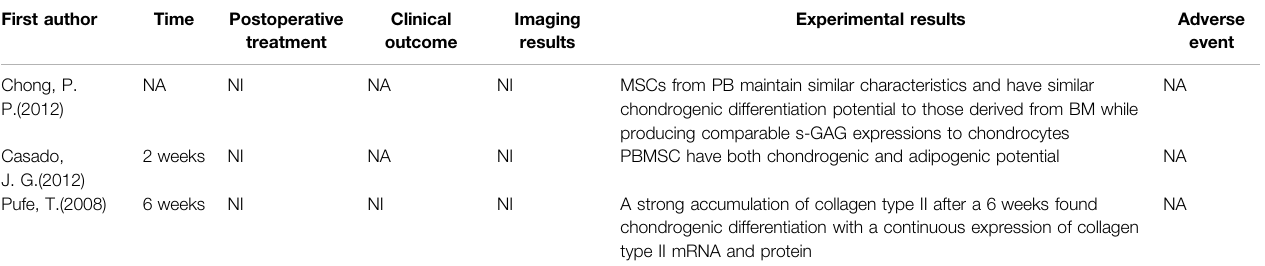
Frontiers in Bioengineering and Biotechnology |